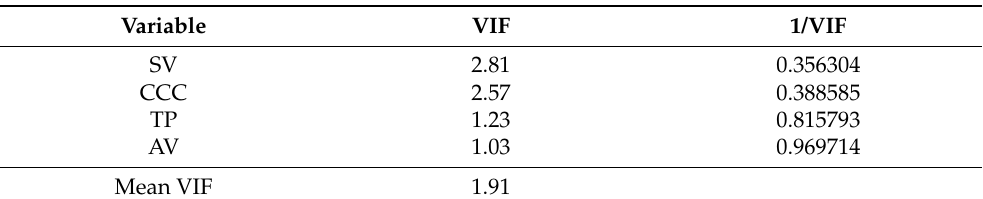
Figure 4. Boxplot for outlier identification and normality for the output of raw data. Table 3.